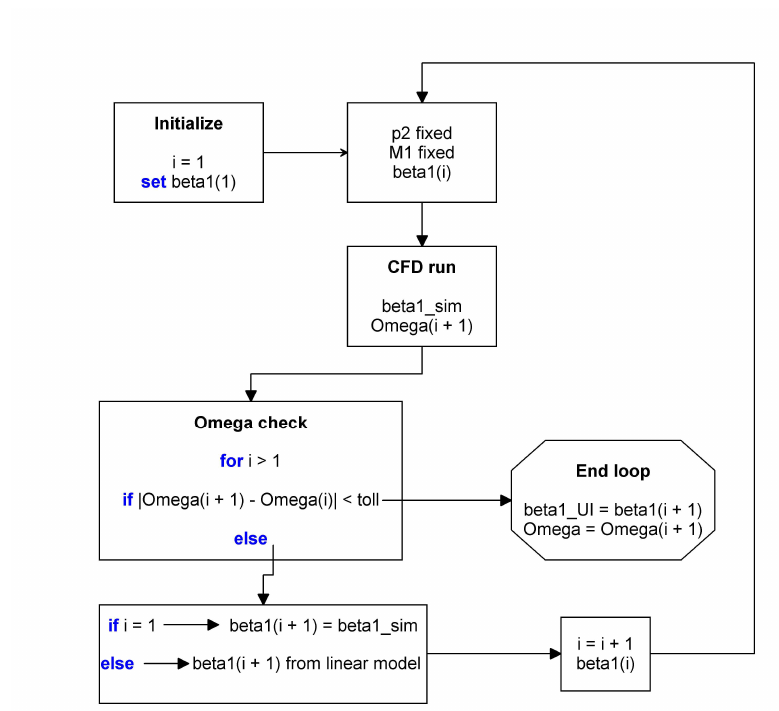
Figure 7. Loop for searching for unique incidence